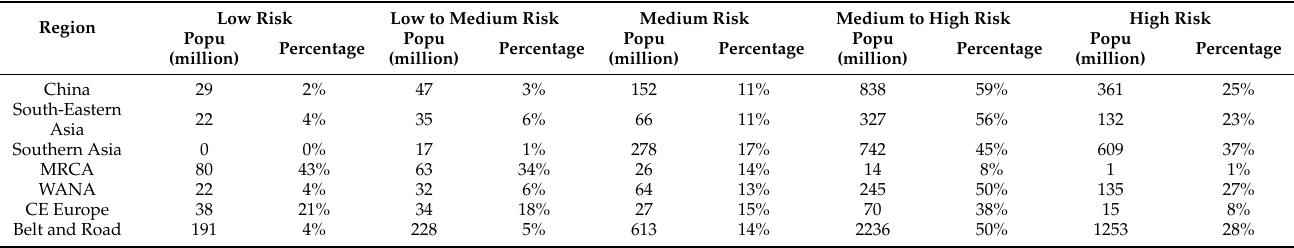
Table 7. Potential impact population along the “Belt and Road” zone by water